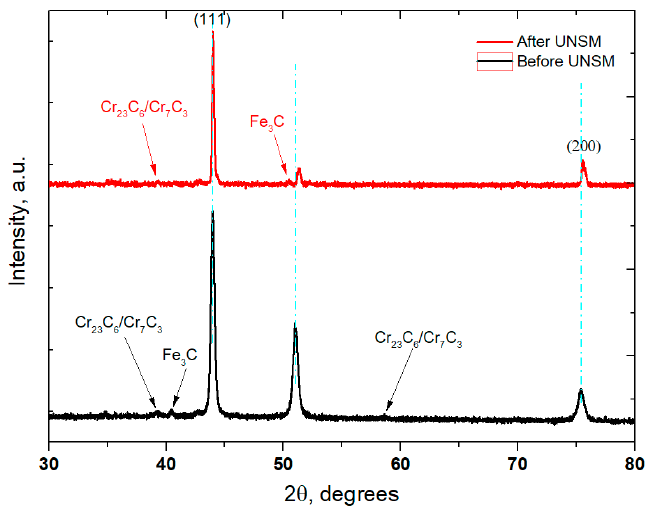
Figure 5. XRD patterns obtained from the surface of the carburized and post-carburized UNSM- treated KHR 45A steel (A).